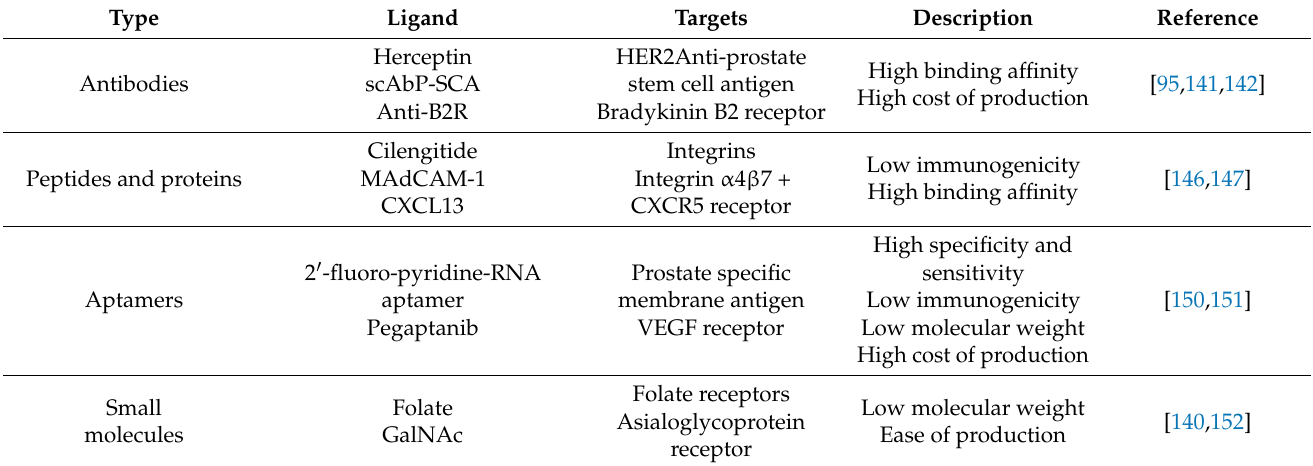
Table 3. Examples of targeting moieties currently used to increase drug